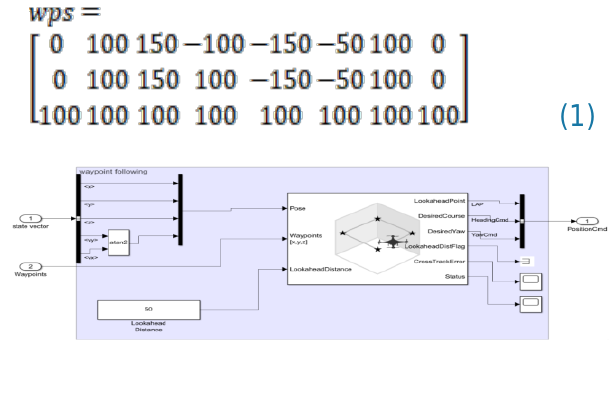
Figure 2. Waypoint subsystem design